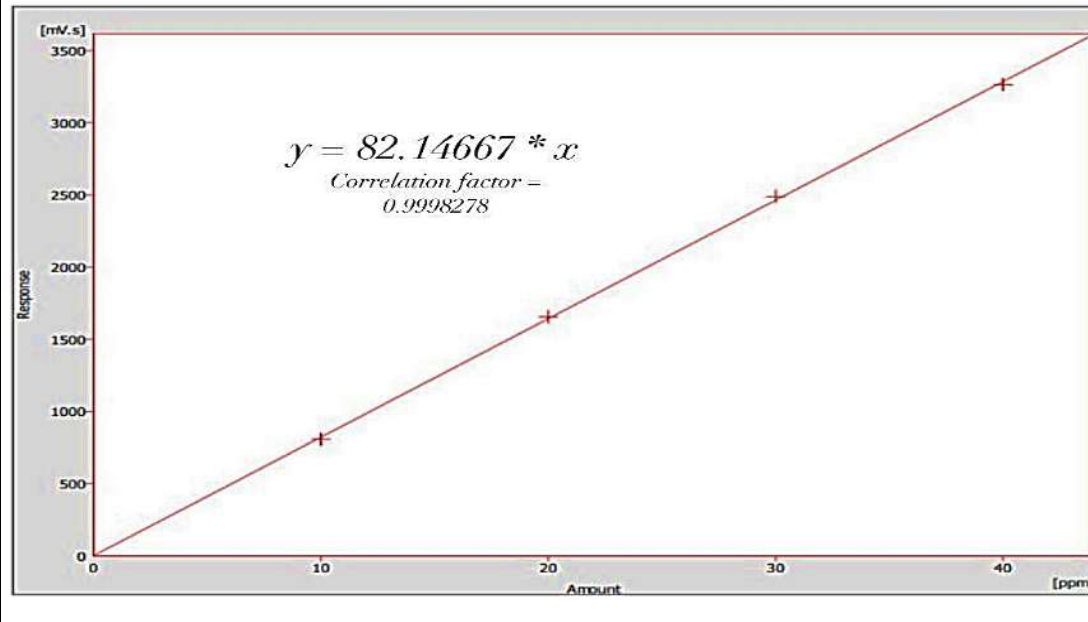
Figure 14. Calibration curve of lupeol